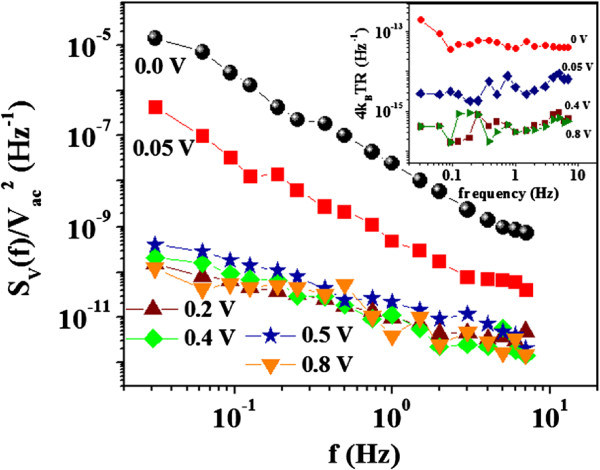
The power spectral densitySV(f)/Vac2as a function of frequencyf at few representative superimposedVdc. The inset shows the Nyquist noise for different Vdc.